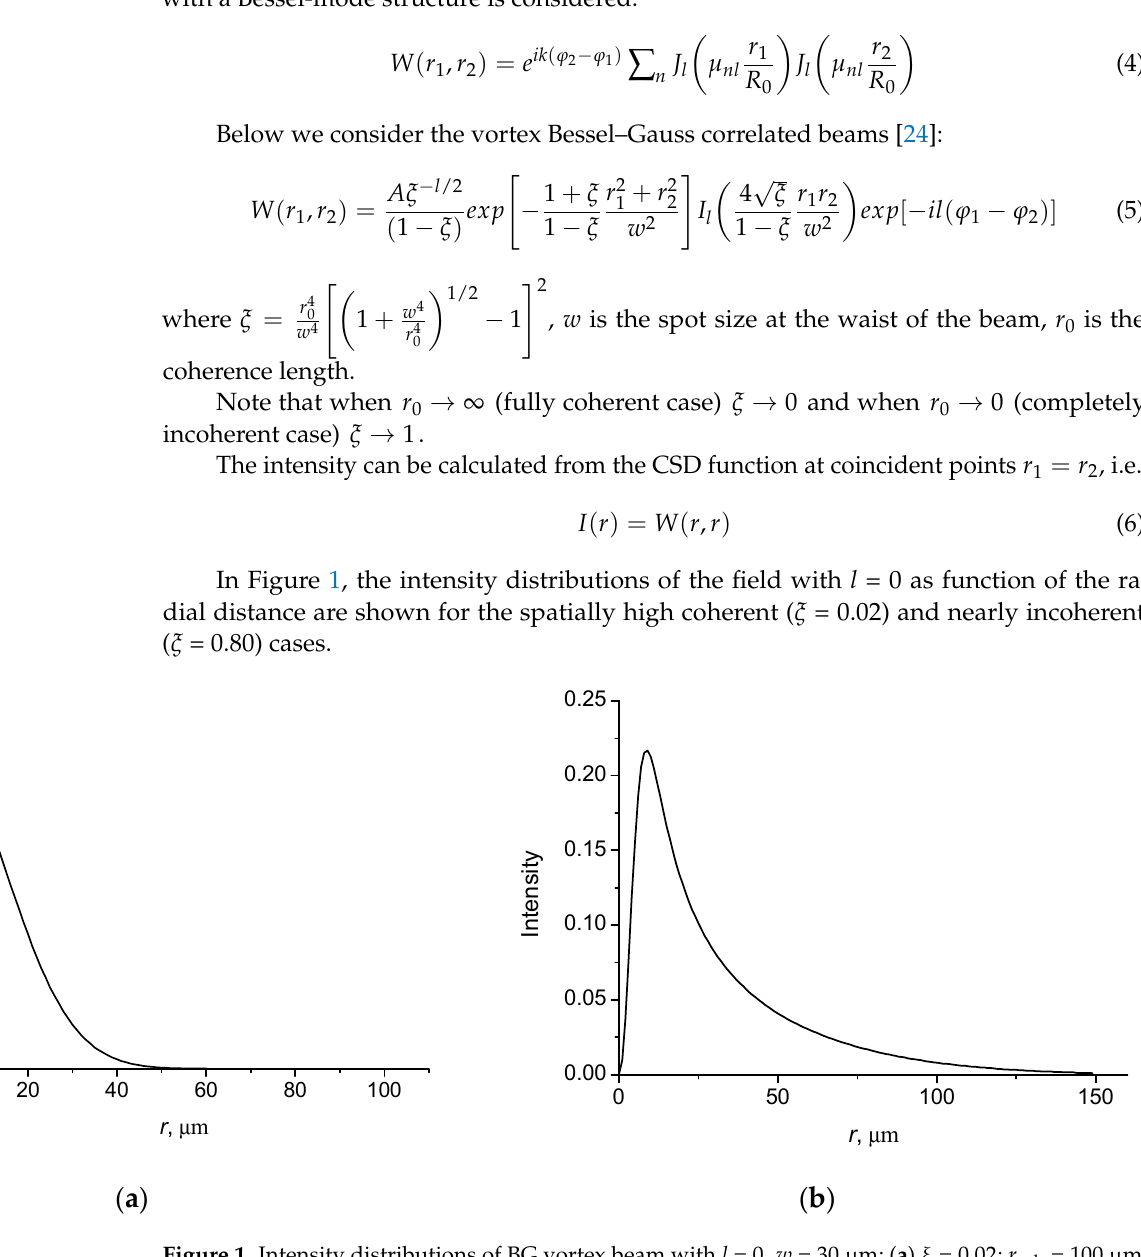
Figure 1. Intensity distributions of BG vortex beam with l = 0. w = 30 µm ; ( a ) ξ = 0.02; r coh = 100 µm ; ( b ) ξ = 0.80; r coh = 10 µm . ( b ) ξ = 0.80; r µ coh = 10